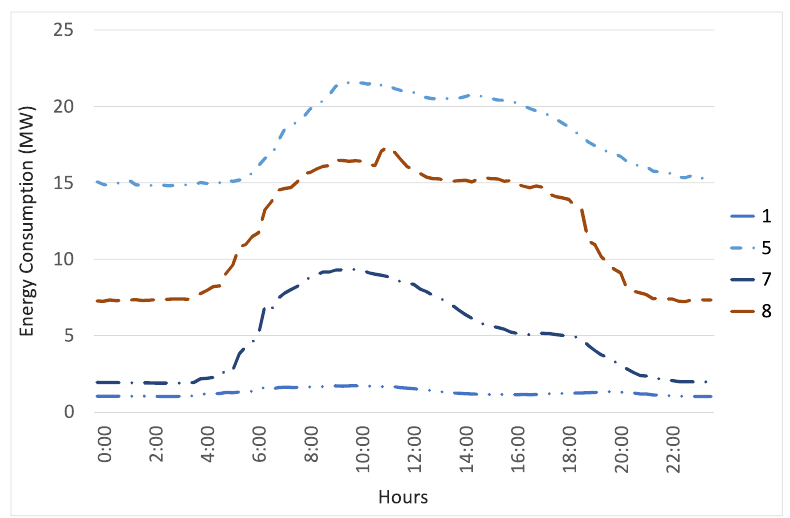
Figure 7. Centroids of the clusters with lower